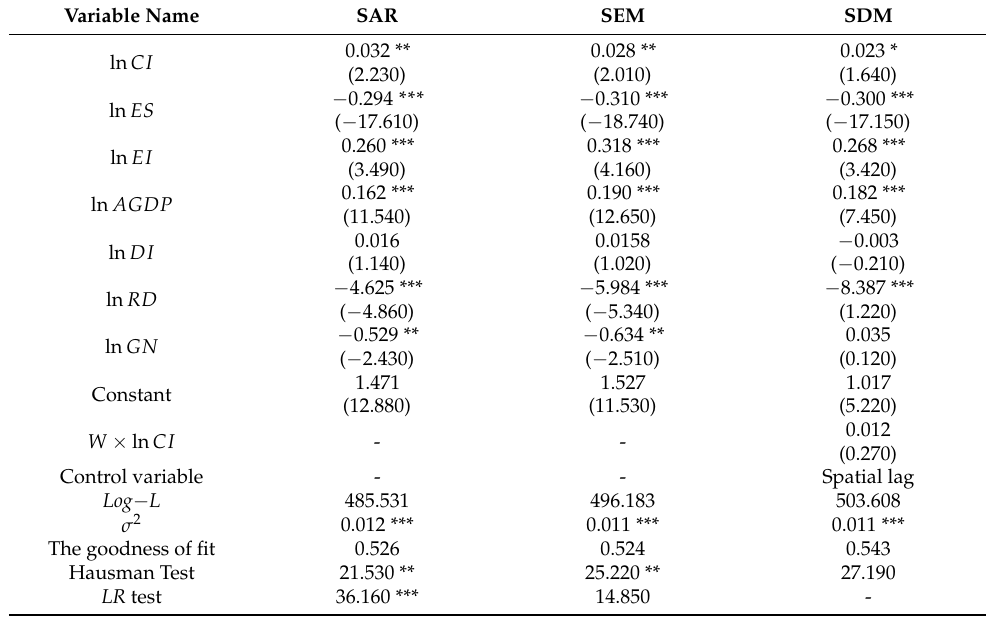
Table 7. Regression results of China’s overall